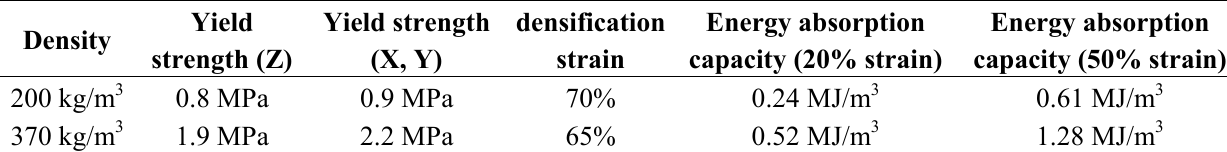
Table 1. Typical material properties for